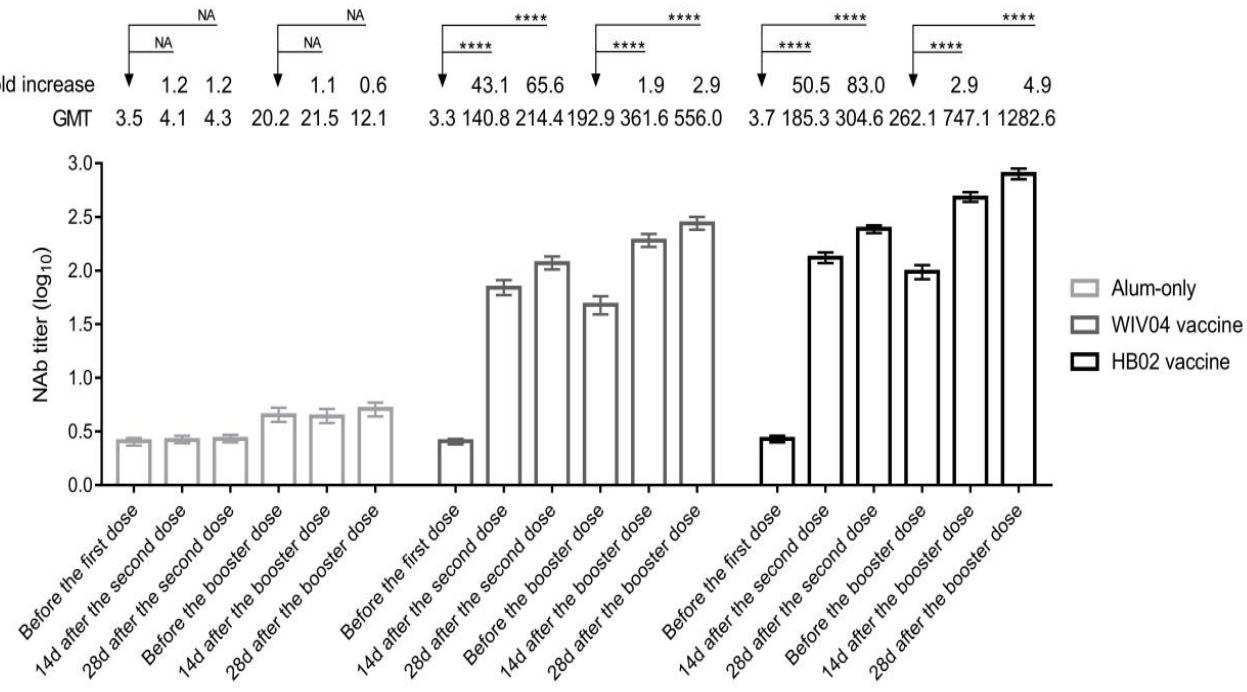
Figure 2. Efficacy of 2 Inactivated Vaccines Against Symptomatic COVID-19 . Cumulative event rates of confirmed symptomatic COVID-19 cases 14 days following a booster dose among participants who contributed at least 1 efficacy follow-up visit, and had negative polymerase chain reaction test results at enrollment (modified full analysis set).